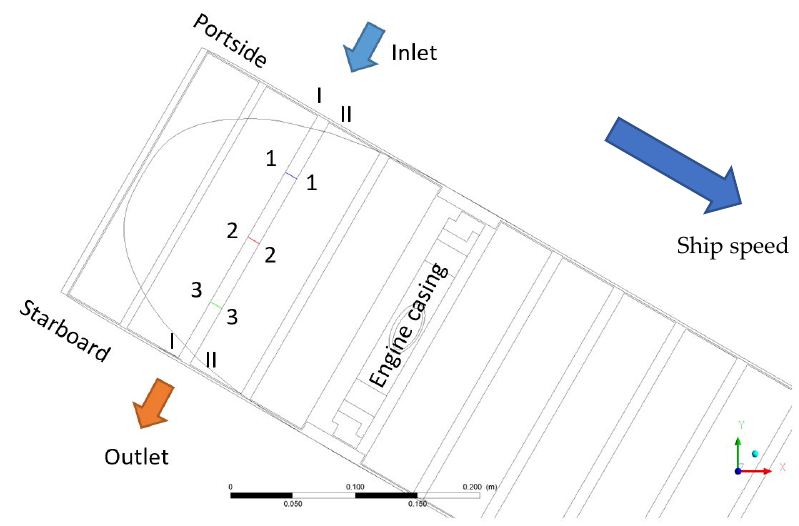
Figure 7. Locations of velocity profiles 1-1 to 3-3 (z = 0.12 m, ψ =30 deg.).